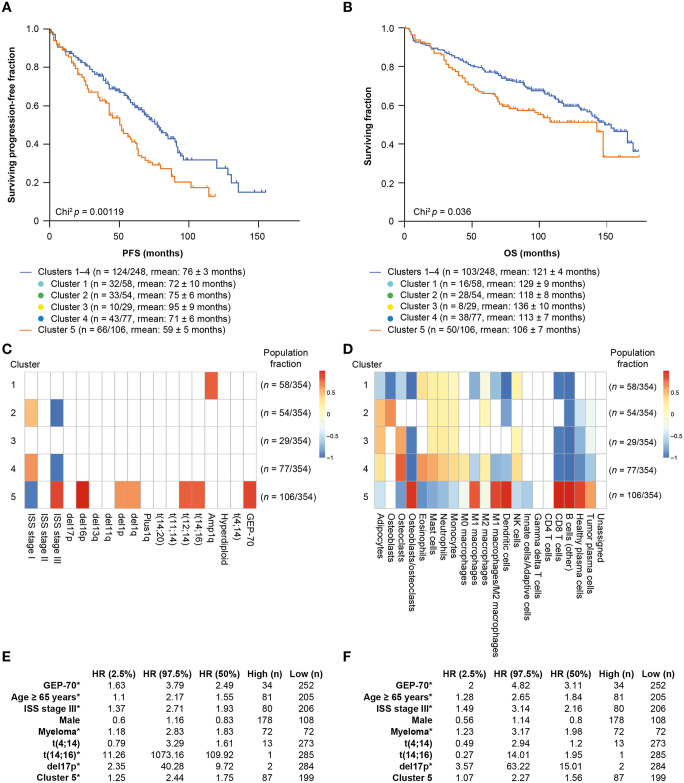
Clinical outcomes and cellular components of microenvironment clusters: Kaplan–Meier curves for pretreatment sample modeling.(A) PFS for the “low-granulocyte” Cluster 5 (orange; n = 66/106; rmean: 59 ± 5 months) versus Clusters 1–4 (blue; n = 124/248; rmean = 76 ± 3 months). (B) OS for the “low-granulocyte” Cluster 5 (orange; n = 50/106; rmean: 106 ± 7 months) versus Clusters 1–4 (blue; n = 103/248; rmean = 121 ± 4 months). (C) Average cytogenetic and clinical characteristic enrichment for patients in each of the 5 clusters. (D) Average deconvolved tumor and stromal cell types present in each of the 5 clusters. FDRs were calculated using Wilcoxon signed-rank test and Benjamini–Hochberg correction. FDRs > 0.05 are white. (E, F) Univariate Cox proportional HRs for PFS and OS (respectively). The analysis considered the upper quartile versus the lowest quartile (or high versus low if binary) for variables in pretreatment samples. Those cell types, ratios, and clinical characteristics marked with an asterisk remain after multivariate Cox proportional hazards lasso regression, implying that they contain independent information about patient outcomes. CD, cluster of differentiation; del, deletion; FDR, false discovery rate; GEP-70, 70-gene Prognostic Risk Score; HR, hazard ratio; ISS, International Staging System; NK, natural killer; OS, overall survival; PFS, progression-free survival; t, translocation.